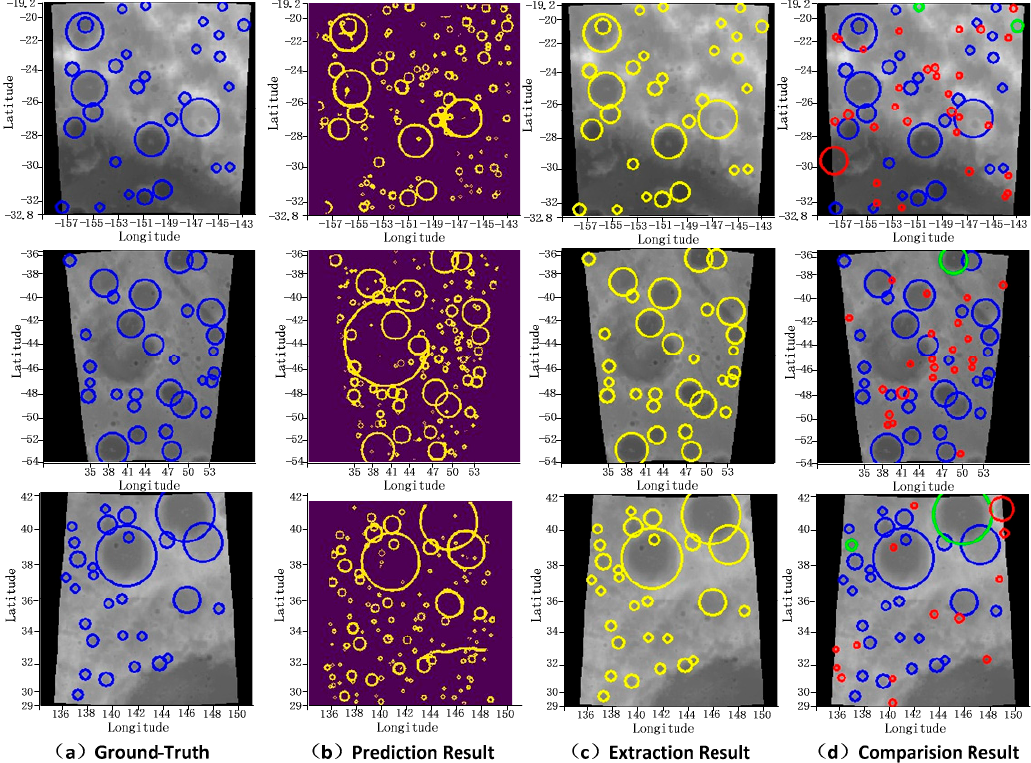
Figure 3. Crater prediction and extraction result by ERU-Net. ( a ) The ground-truth label of lunar images. Blue circles denote the ground-truth craters. ( b ) CNN (convolution neural network) prediction results. ( c ) Crater extraction results from prediction results. ( d ) The recognition result of our method is compared with the ground-truth. Blue circles denote the correctly recognized craters, red circles denote unrecognized craters, and green circles denote new craters that are predicted by our network.